Question: What kind of plot is shown here?
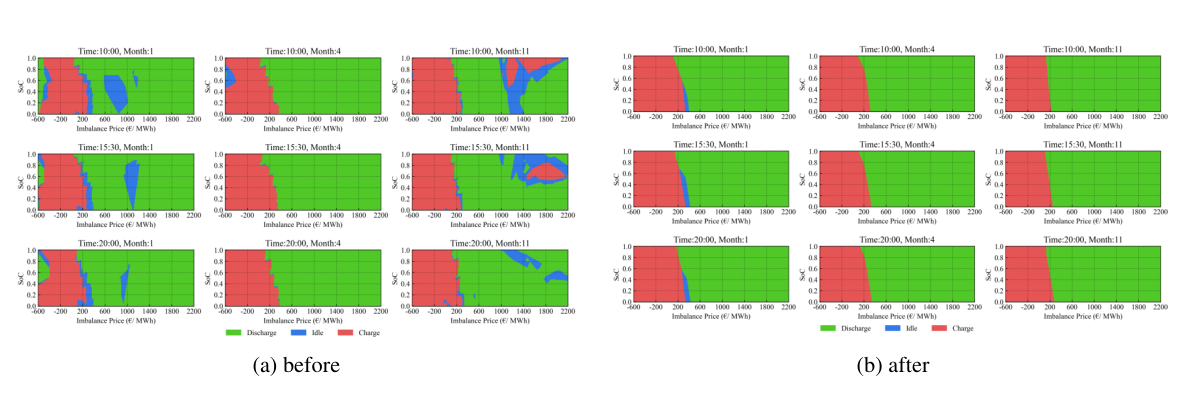
Answer: heatmap